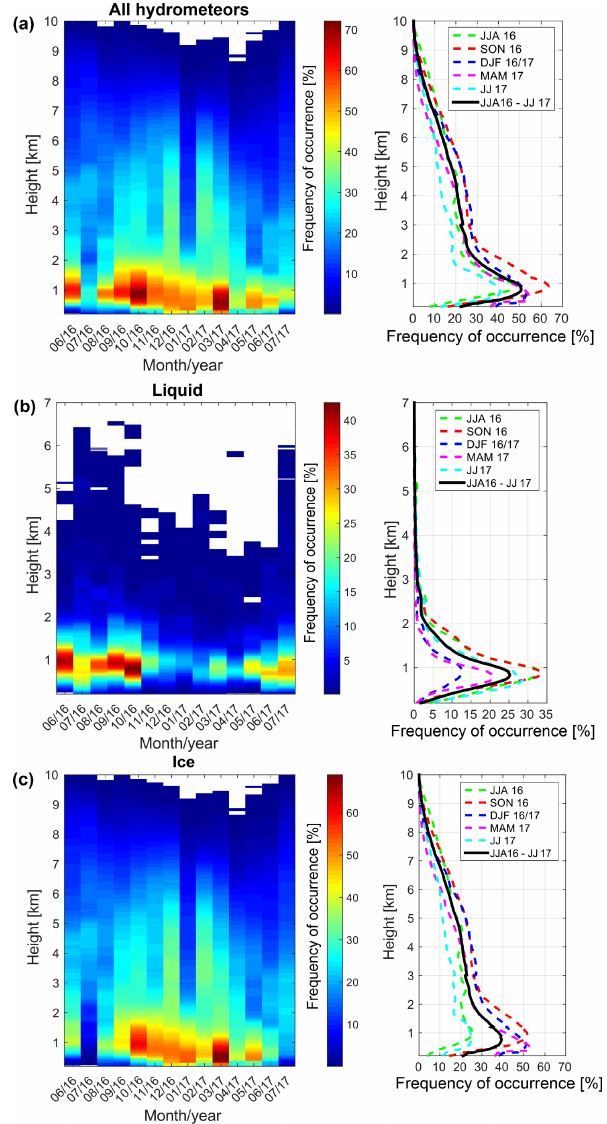
Figure 8. Monthly, seasonal, and total (for the whole time period) frequency of occurrence of all hydrometeors (a) , liquid (b) , and ice (c) as a function of height for the period from June 2016 to Au- gust 2017. Frequency of occurrence is given in % and normalized to the total number of Cloudnet profiles for each month.